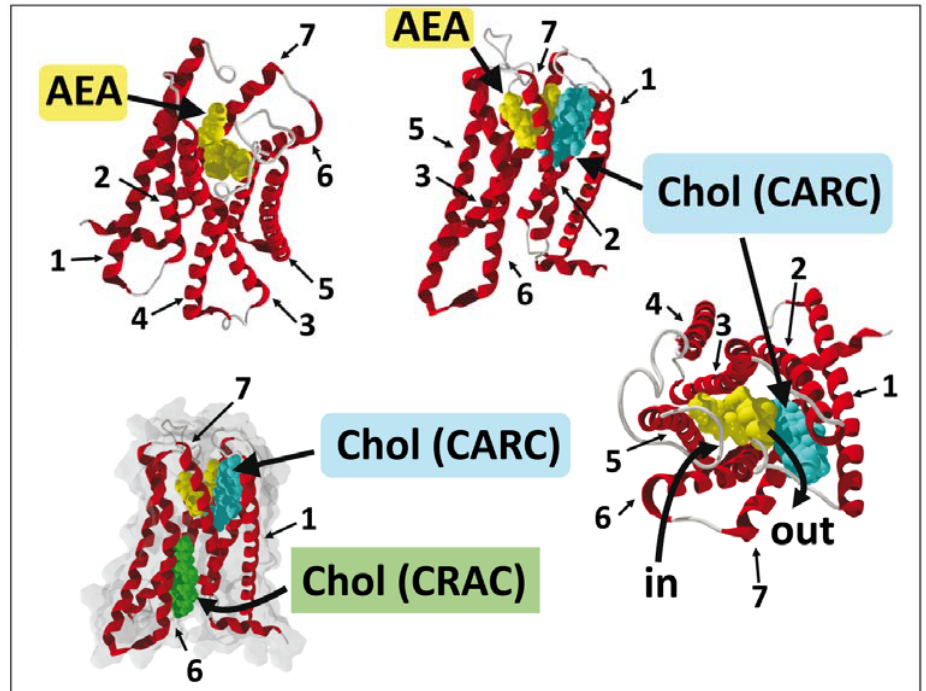
Figure 7. Docking of AEA in the CB1 receptor. Several views of the AEA/CB1 complex, with and without cholesterol (Chol) are shown. The transmembrane helices (TMH) domains (numbered from 1 to 7) of the CB1 receptor (retrieved from PDB file 5XRA) are in red. Anandamide (in yellow) was docked in the ligand binding pocket. Note the typical L ‐ shape conformation of AEA bound to the receptor (upper left panel). Two cholesterol molecules bound to the seventh TMH in a typical CARC/CRAC mirror position are shown in the lower left panel (cholesterol bound to CARC is in cyan, the one bound to CRAC is in green). The entry (in) and exit (out) pathways of AEA are indicated (right panel). Molecular docking was performed by J. Fantini according to the method described in reference